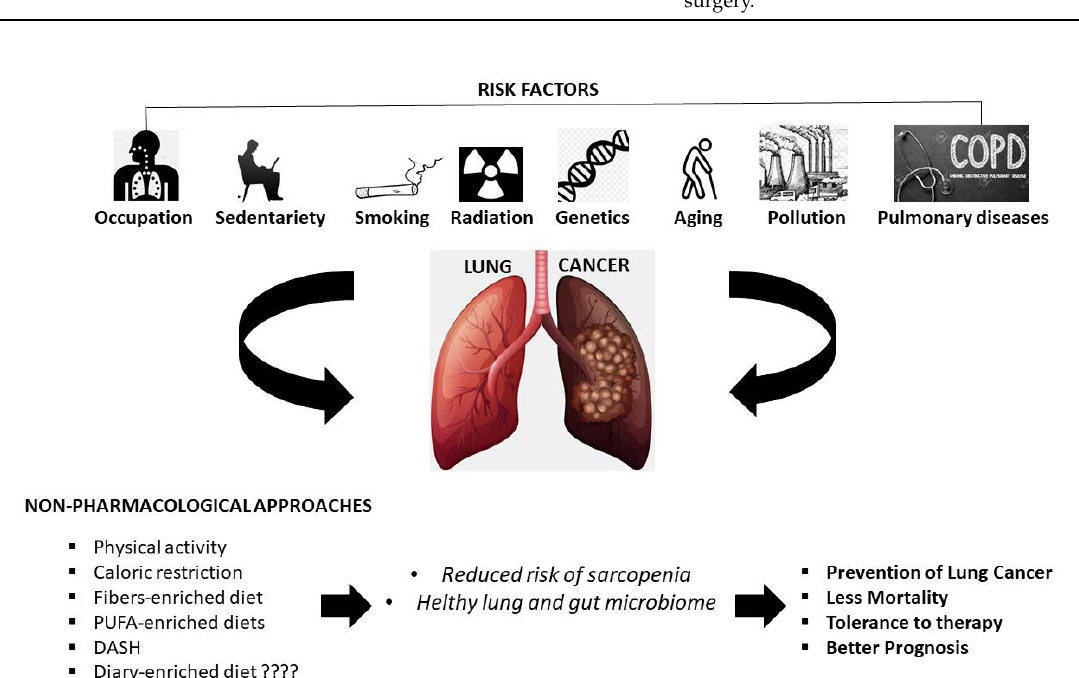
Figure 2. Non-pharmacological approaches acting on lung cancer incidence and management. Regular physical activity, caloric restriction, fibers-enriched diet, PUFA-enriched diets, DASH and diary-enriched diet may reduce the risk of sarcopenia and influence lung and gut microbiome resulting in decreased cancer incidence, reduced mortality, tolerance to therapy and a better prognosis.